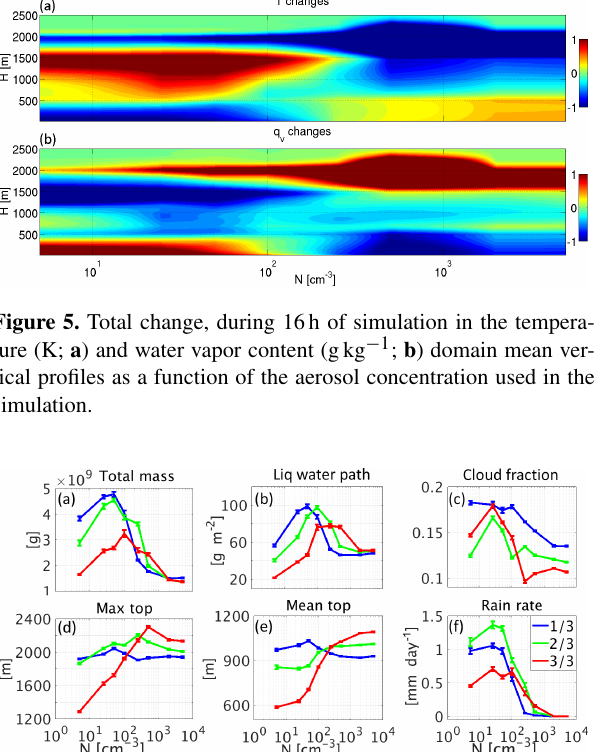
Figure 6. Mean properties (over time and domain) of the sim- ulated cloud fields as a function of the aerosol concentration used in the simulation: (a) total liquid water mass in the do- main, (b) cloudy LWP, (c) CF for columns with τ >0.3, (d) max- imum cloud top, (e) mean cloud top and (f) surface rain rate. Each property is calculated separately for each period of one-third of the simulations (blue, green and red for the first, second and third pe- riods, respectively). The error bars present the standard error. For details about the different properties, see the